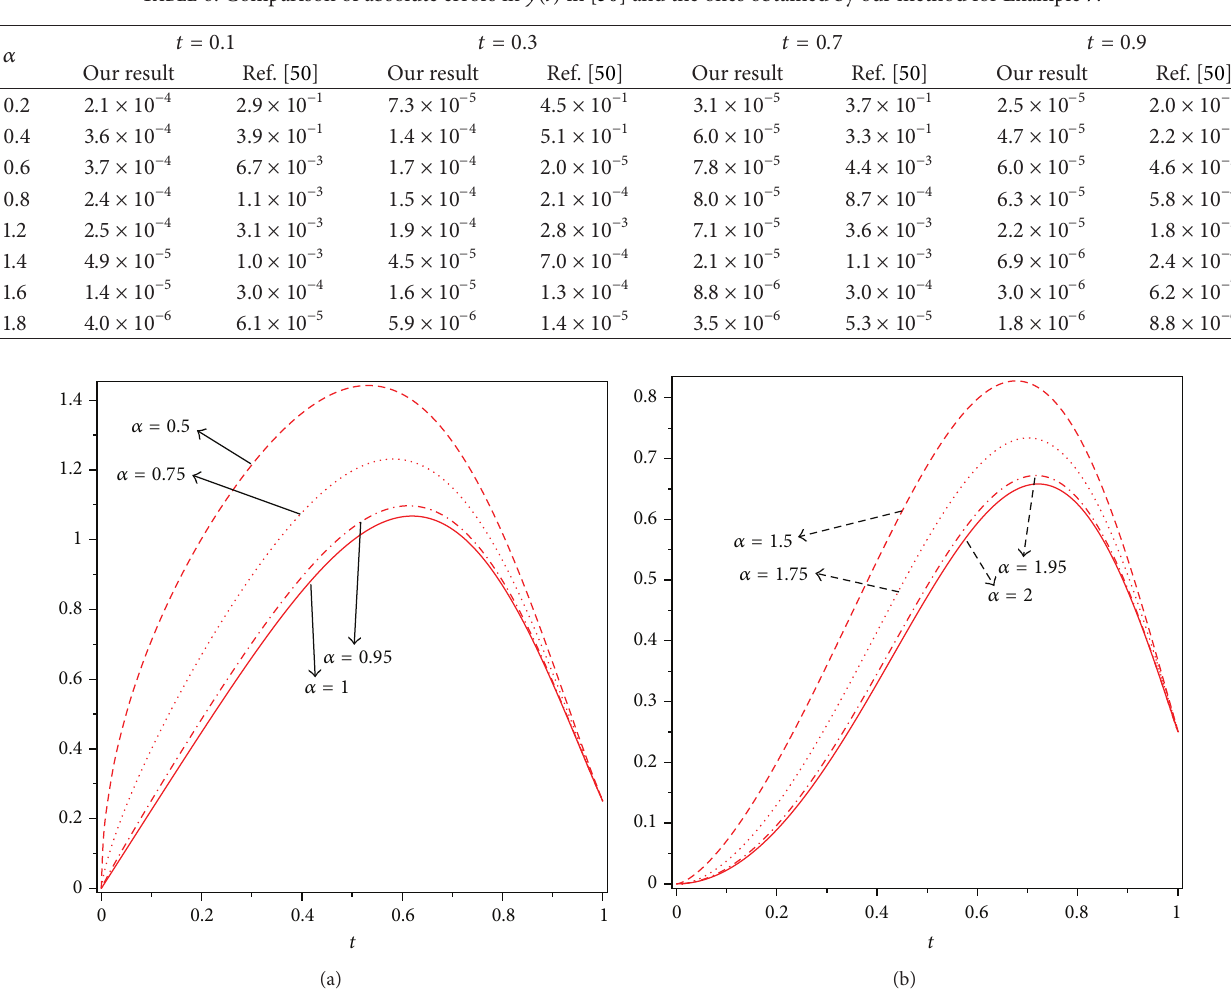
Figure 2: Comparison of 𝑦(𝑡) for 𝑀 = 12 , 𝑘 = 4 , and (a) 𝛼 = 0.5, 0.75, 0.95, 1 , (b) 𝛼 = 1.5, 1.75, 1.95, 2 for Example